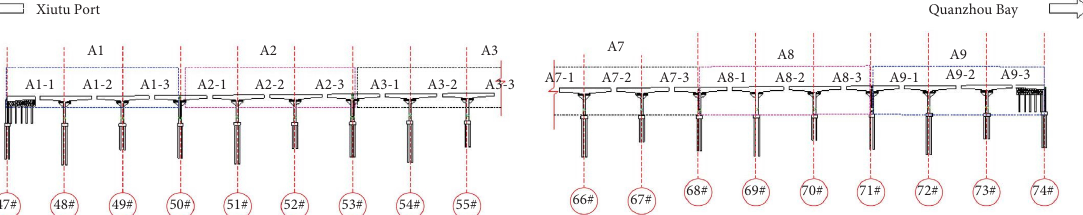
Figure 1: Number of each joint closure entrance.